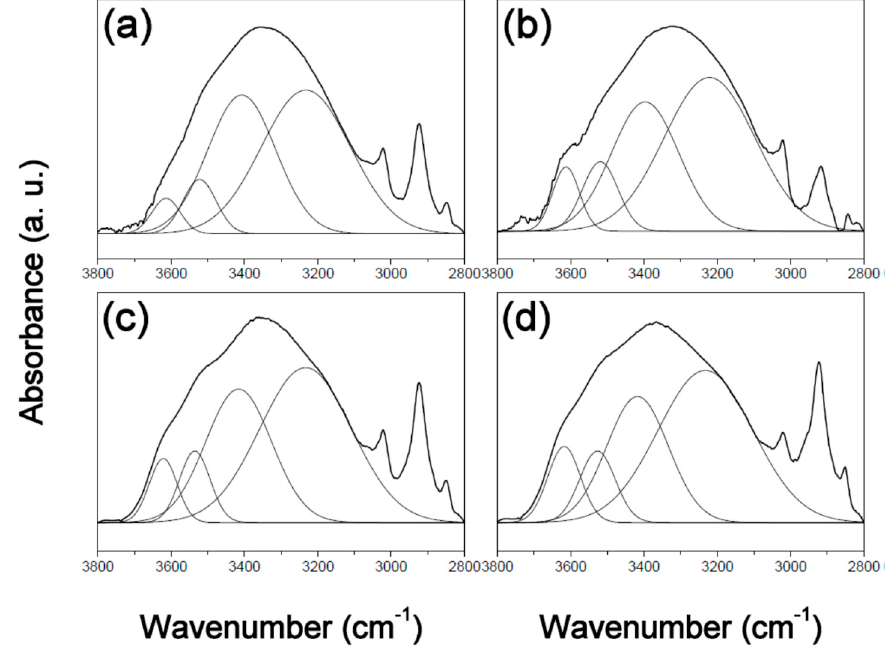
Figure 3. FT-IR spectra of poly(vinyl phenol) prepared in ethyl-3-ethoxypropionate (PVPh-E) thermally treated at 180 °C for ( a ) 0, ( b ) 1, ( c ) 4, and ( d ) 8h, overlaid with Gaussian-fitted curves.